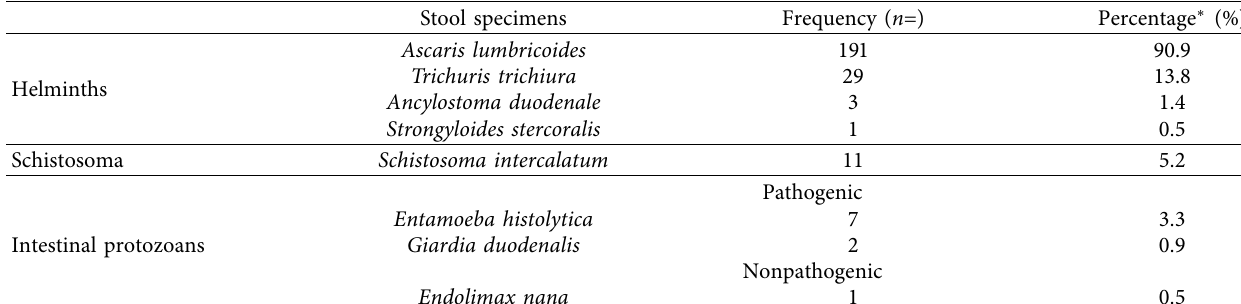
Table 2: Parasites identifed in the 210 positive copro-parasitological